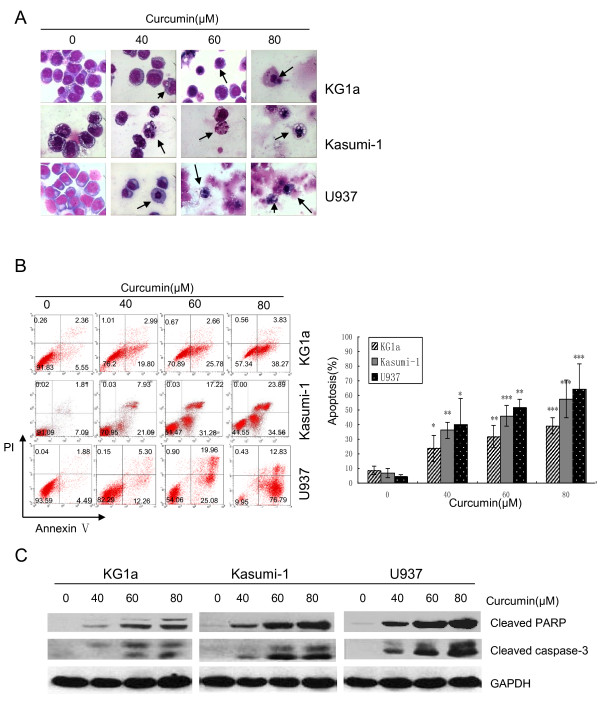
Curcumin induced apoptosis through activation of caspase-3 followed by PARP degradation. KG1a, Kasumi-1 and U937 cells were incubated with indicated concentrations of curcumin for 24 h. (A) Cells were stained with Wright-Giemsa and then examined under a light microscope. Arrows indicate apoptotic cells (magnification ×400). (B) Cells were stained with Annexin V/PI to analyze apoptotic cell populations. The graph displays the means ± SD of four independent experiments. (C) Western blotting analysis showed cleaved caspase-3 (17, 19 kDa) and cleaved PARP (89 kDa) fragment. Three independent experiments were performed with similar results, and representative data are shown.